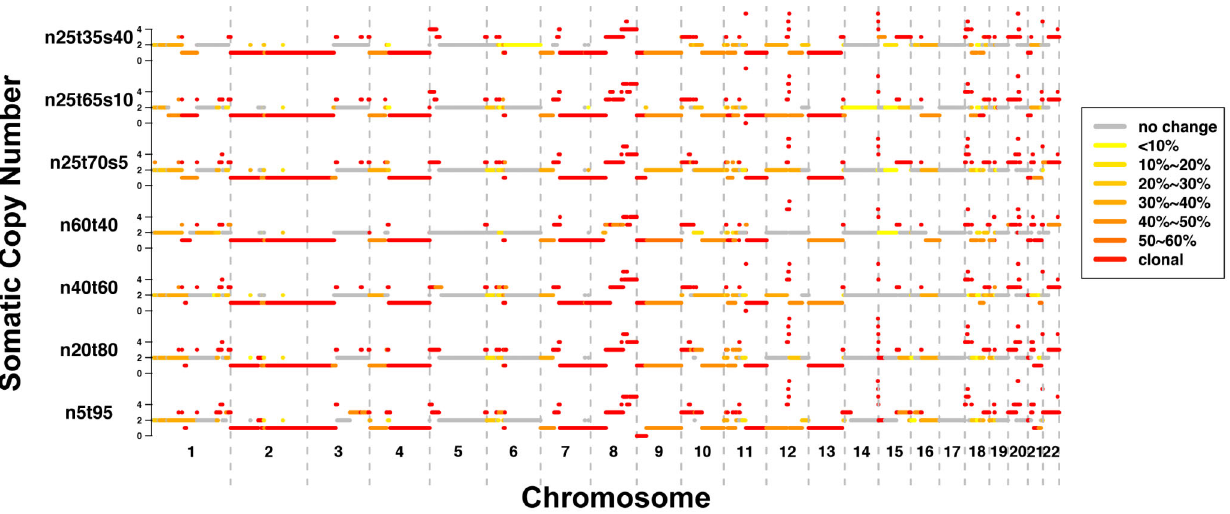
Figure 4. Somatic copy number and subclonality characterization for TCGA benchmark HCC1143 samples. The calling result is consistent across samples with different mixing proportion of normal cells, which demonstrates the robustness of SomatiCA to different extent of contamination.